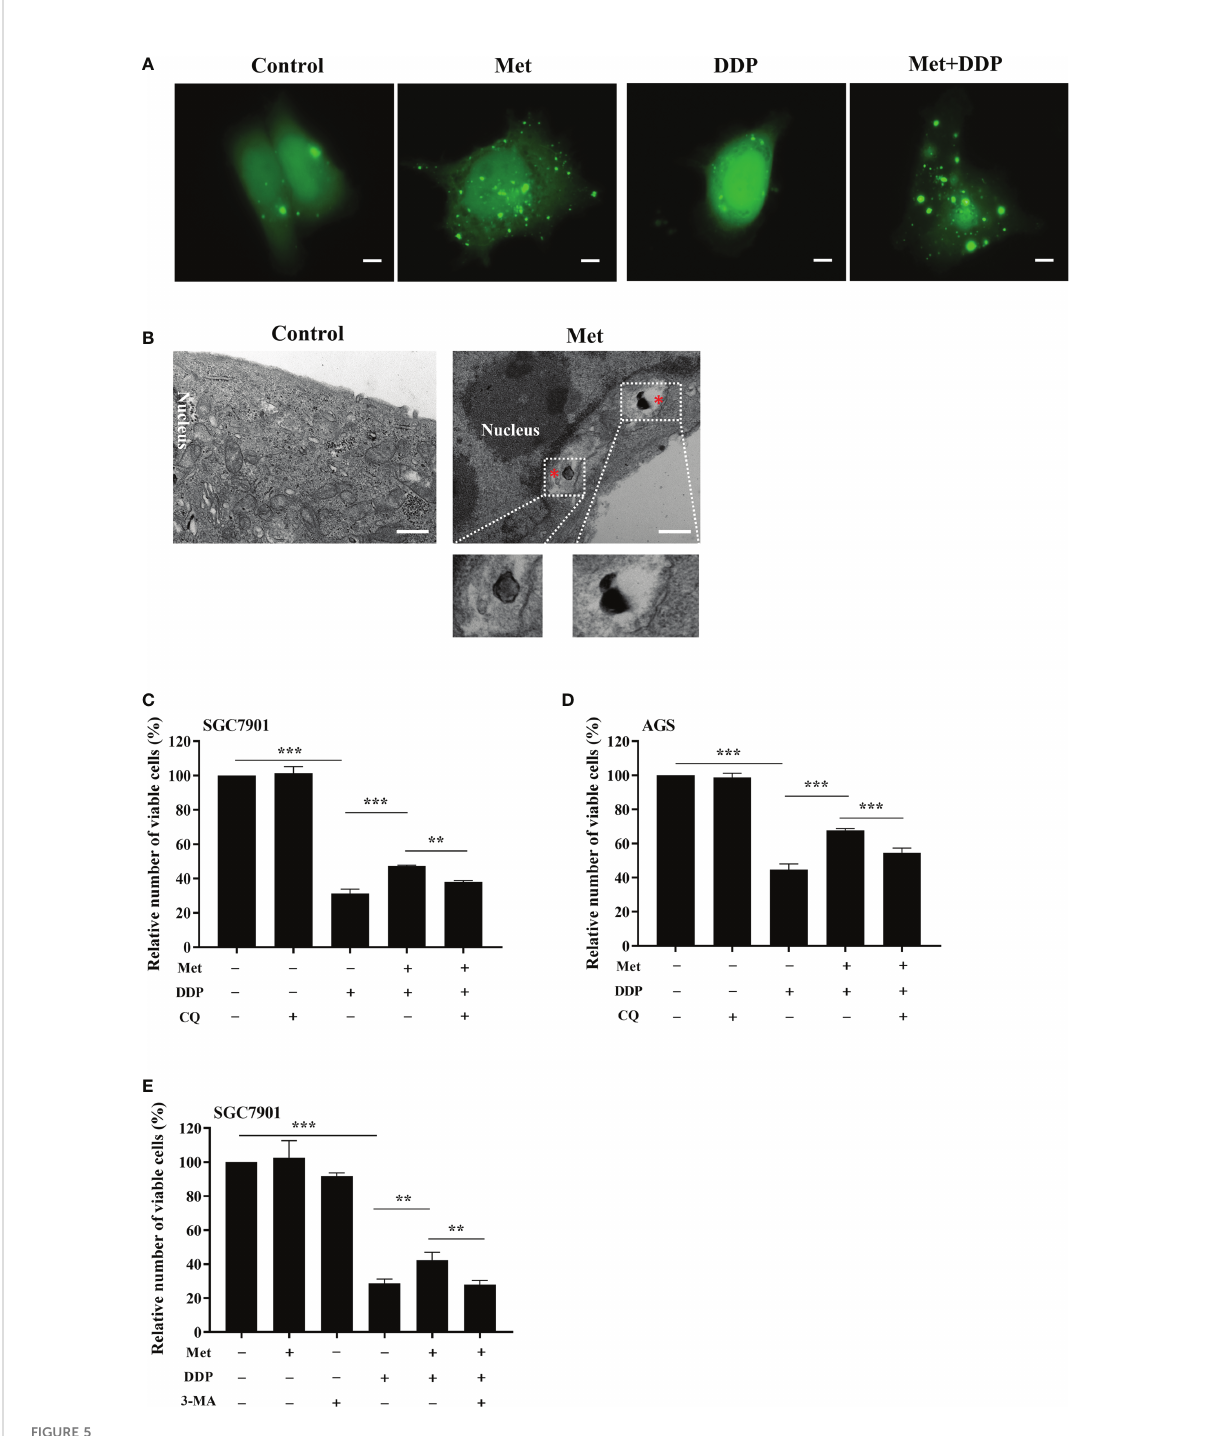
FIGURE 5 Metformin promoted cisplatin resistance via mitophagy in GC cells. (A) SGC7901 cells were transfected with pEGFP-LC3B for 24 h. Then cells were treated with indicated drug and analyzed by fl uorescence microscopy. Scale bar=5 µm. (B) SGC7901 cells were treated with metformin and analyzed by transmission EM. Asterisk represents mitophagy vesicles. Circled images at higher magni fi cation are shown in the below panels. Scale bar=0.5 µm. (C, D) SGC7901 and AGS cells were pre-treated with 10 mM metformin followed by co-treating with DDP in the absence or presence of 10 m M CQ for 24 (h) Cell viability was analyzed by CCK8 assay. (E) SGC7901 cells were pre-treated with 10 mM metformin followed by co-treating with cisplatin in the absence or presence of 5 mM 3-MA for 24 h. Cell proliferation was analyzed by CCK8 assay. Data were presented as the means ± SD. The experiments were repeated three times independently. ** p <0.01, *** p